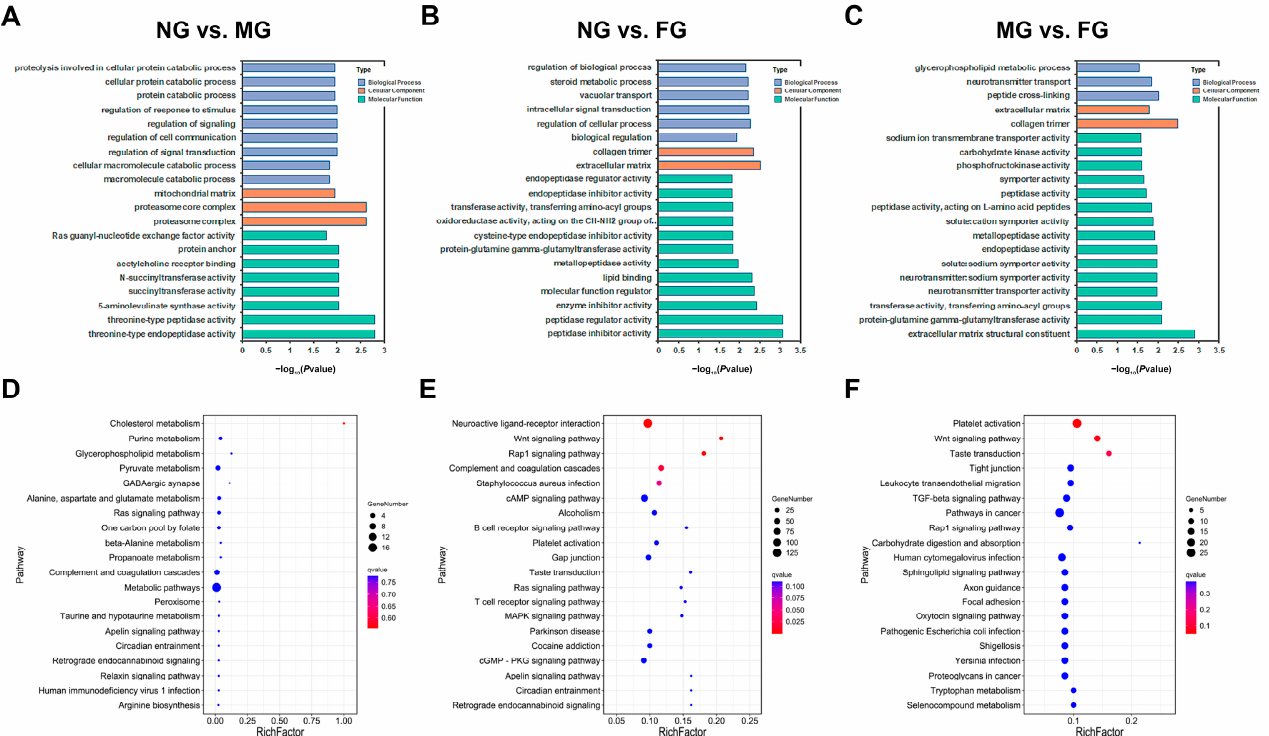
Figure 4. GO and KEGG functional enrichment analysis of DEGs in the comparison groups of NG, MG, and FG. ( A – C ) GO profiling of DEGs in all three comparison groups. ( D – F ) KEGG pathway analysis of DEGs in all three comparison groups.